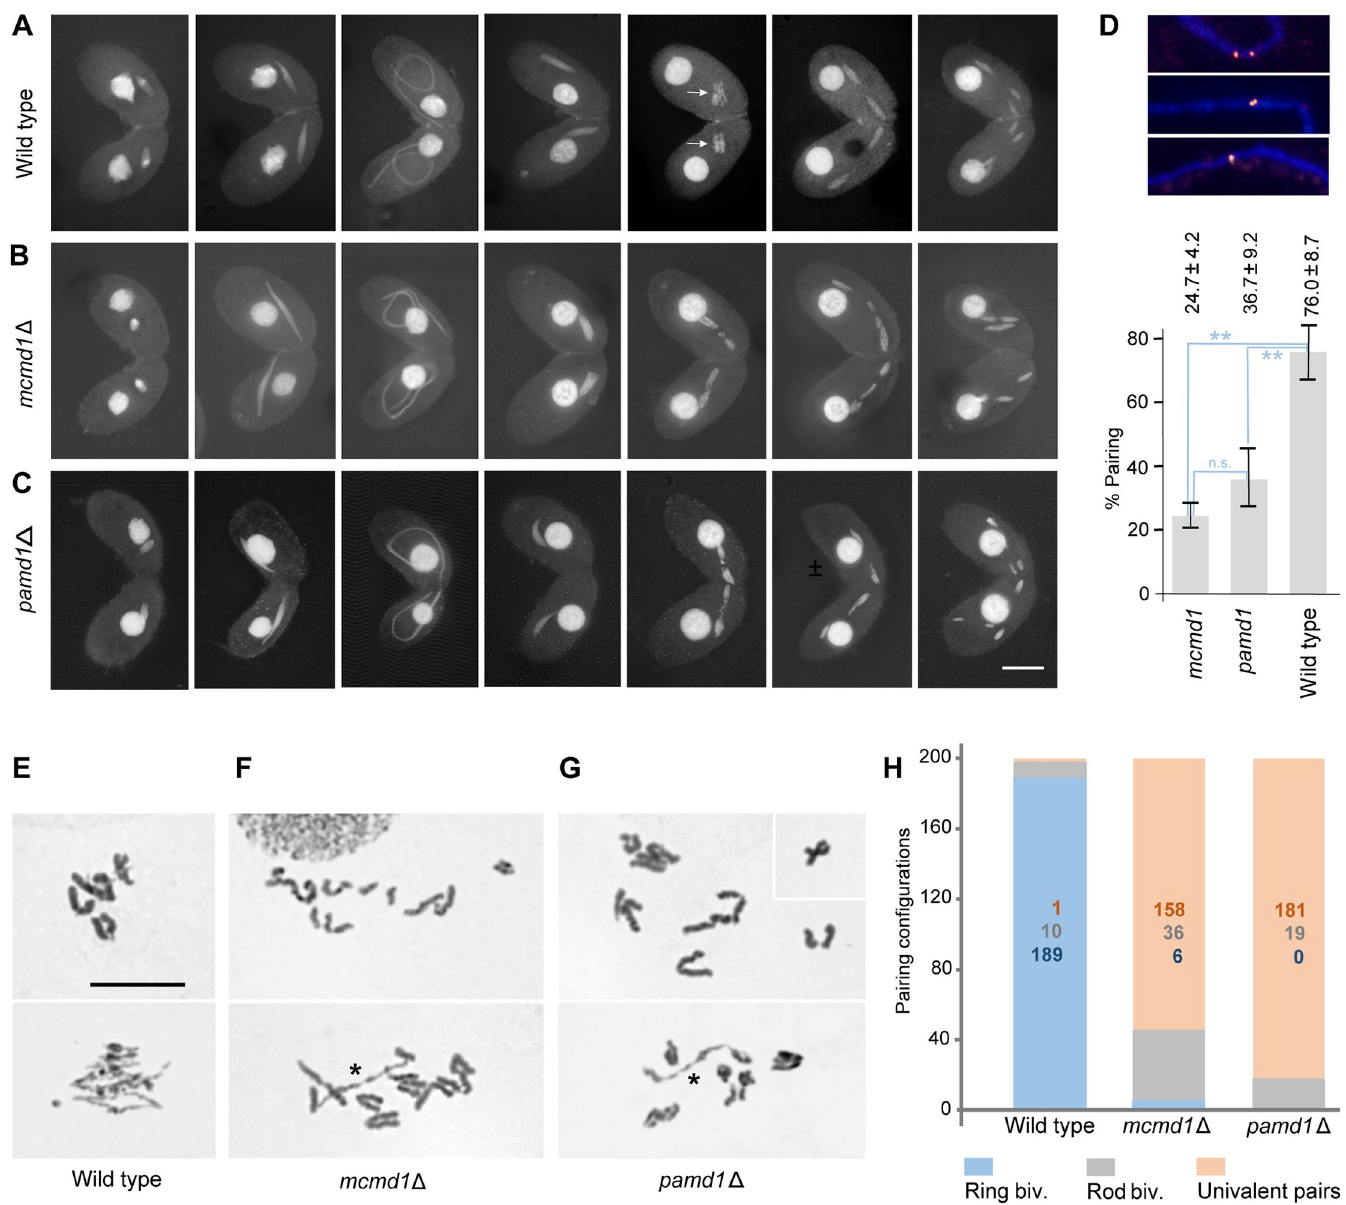
Fig 2. Meiotic stages and chromosome configurations in wild-type and mutant cells. (A–C) Meiotic progression in (A) wild-type, (B) mcmd1 Δ , and (C) pamd1 Δ cells. Arrows in (A): Metaphase plate. (D) Pairing of homologous loci marked by FISH, with examples of single signals and two joined signals (scored as paired), and two separate signals (scored as unpaired). Error bars represent the SD from three counts of 50 nuclei each. Paring was significantly reduced in mcmd1 Δ (t-test: p- value = 0.003248) and pamd1 Δ (t-test: p-value = 0.005888) cells compared to wild-type cells, and did not differ significantly (n.s.) between the two mutants (t-test: p- value = 0.1398). (E–H) Diakinesis–metaphase I configurations (Giemsa staining). (E) Diakinesis (top) and metaphase (bottom) in the wild type with five bivalents. At diakinesis centromeres are stretched out with thin tips due to the start of microtubule attachment. Bivalent arms on both sides of the centromeres are in close contact, suggesting the presence of chiasmata in both arms. During metaphase, bivalents are arranged in a metaphase plate. Most of them are ring-shaped, indicating chiasma formation in both arms. (F) Examples of the mcmd1 Δ diakinesis–metaphase stages. Chromosomes mainly form univalents. (G) Examples of the pamd1 Δ diakinesis– metaphase stages with univalents. Univalents never assemble into a metaphase plate and become prematurely oriented toward the poles in a random fashion. The asterisks denote rod bivalents. Bars: 10 μ m. (H) Quantification of bivalent (biv.) and univalent configurations. A total of 200 chromosome pairs were evaluated for each